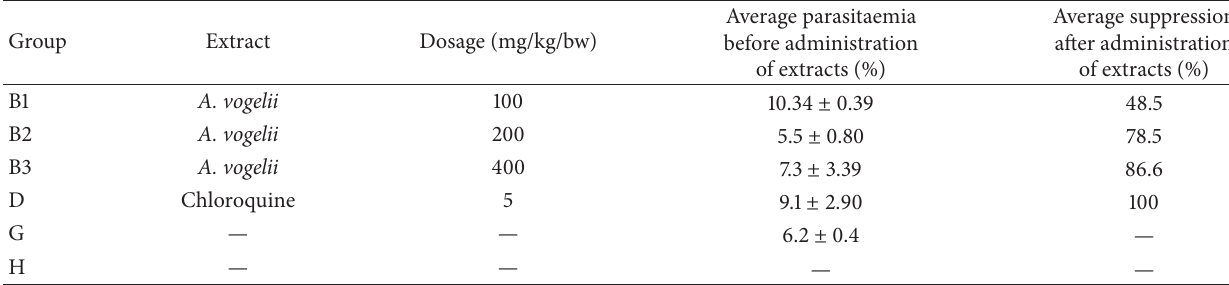
Table 3: Baseline parasitaemia and